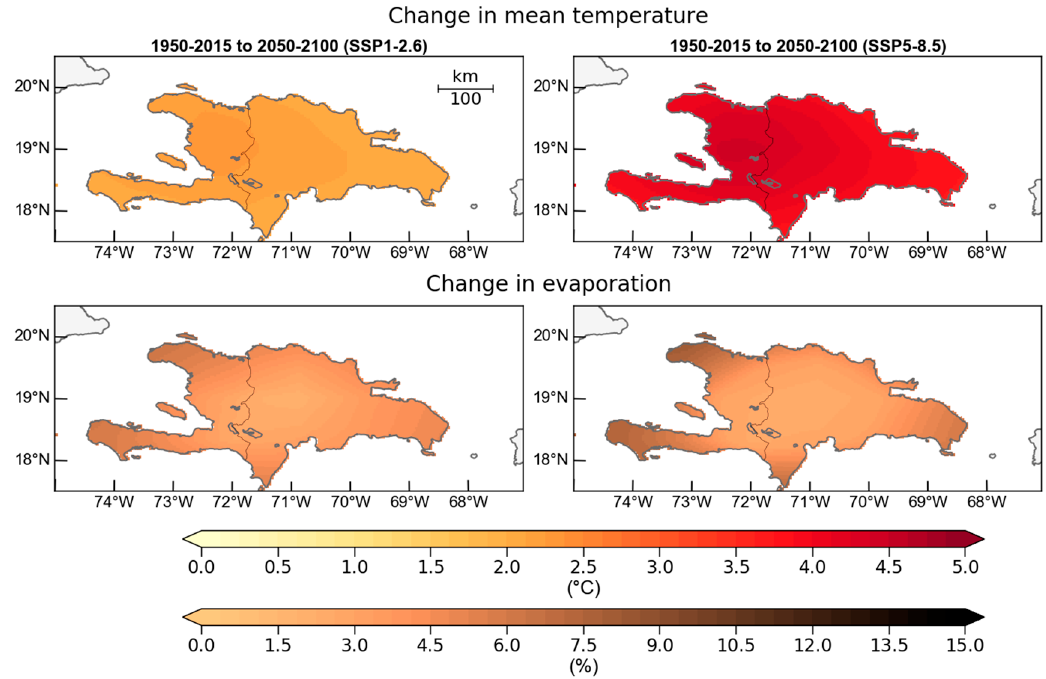
Figure 6. Multimodel means of the projected changes in surface temperature and water evaporation flux on Hispaniola Island from CMIP6. The upper panels show the changes in surface temperature following the shared socioeconomic pathway (SSP) 1–2.6 to the left, and SSP 5–8.5 to the right. For display purposes, we bilinearly interpolated the results to a common 0.04° × 0.04° (4 km) horizontal resolution to match with our high-resolution products. Changes in the projected temperatures means are relatively homogeneous (Figure 6).